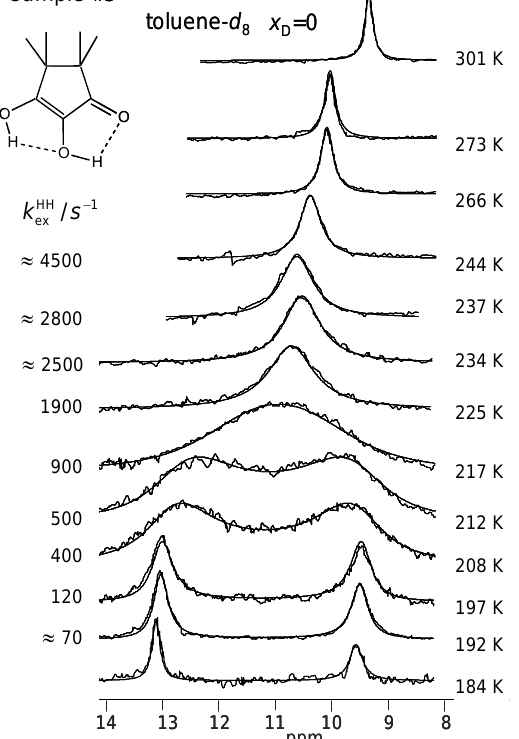
Figure 9. Variable temperature superimposed experimental and simulated 1 H NMR signals of the hydroxyl groups of TMRA dissolved in toluene- d 8 (sample #3). The simulation parameters are assembled in Table 2. For further explanation see text.